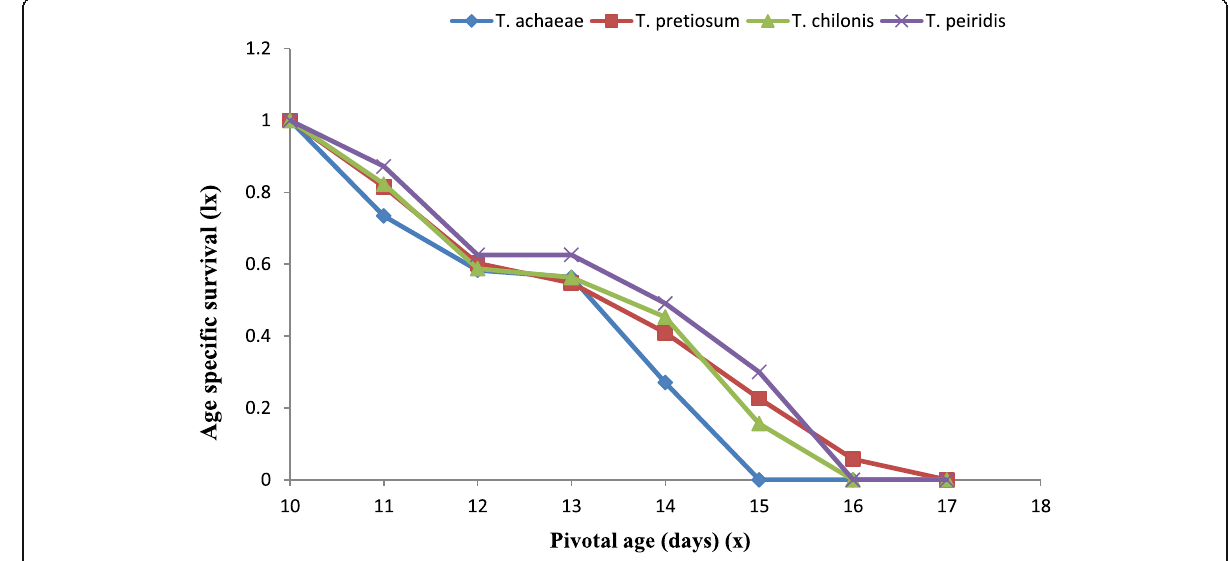
Fig. 1 Comparison of age-specific survival (l x ) of Trichogramma spp. on Tuta absoluta